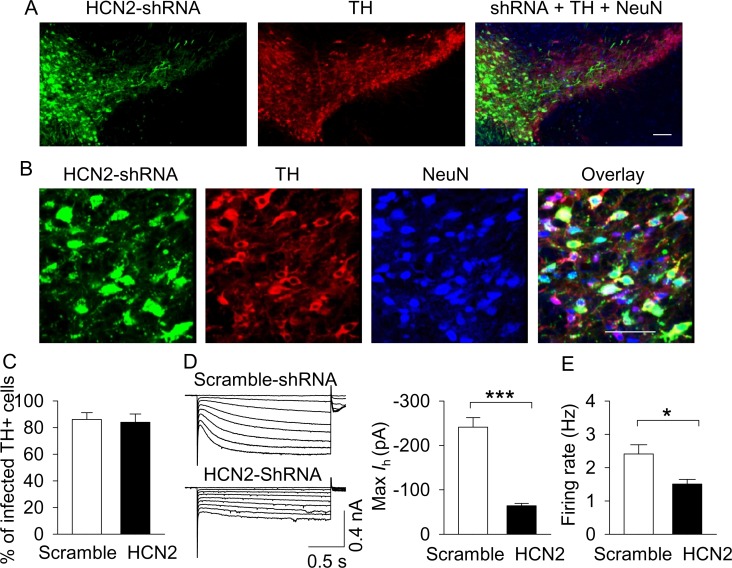
AAV-mediated shRNA knockdown of HCN2 in the VTA.(A,B), Immunofluorescence labeling showing the expression of AAV2-HCN2-shRNA-eGFP (green), TH (dopamine neuron marker, red) and NeuN (neuronal marker, blue) in the midbrain under low magnification (A) and high magnification (B). Scale bars: 50 µm. (C), The percentage of TH+ VTA dopamine neurons that were infected with AAV2-HCN2-shRNA-eGFP or scramble-shRNA (n = 3 mice/group). (D), Maximal Ih current amplitude was significantly decreased in AAV2-HCN2-shRNA-eGFP-infected dopamine neurons (n = 14 from three mice) compared with AAV2-scramble-shRNA-eGFP-infected dopamine neurons (n = 15 from four mice; ***p<0.001). (E), AP firing frequency was decreased in AAV2-HCN2-shRNA-GeFP-infected neurons (n = 10 from three mice) compared with AAV2-scramble-shRNA-eGFP-infected neurons (n = 9 from four mice; *p=0.036).10.7554/eLife.32420.015Figure 6—source data 1.Ih current and AP firing following shRNA-mediated HCN2 knockdown in Figure 6C–E.